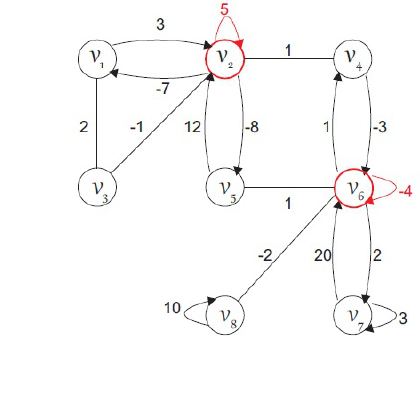
Figure 1: (a) Digraph of matrix M 1 (b) Digraph of matrix M 2